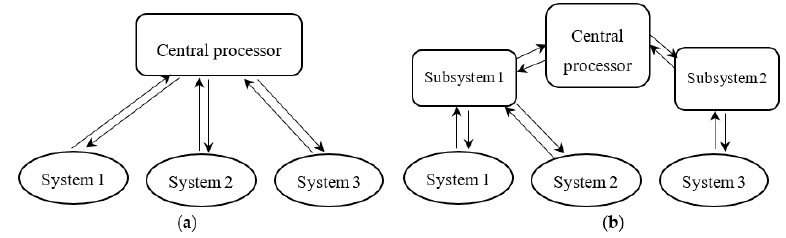
Figure 8. Centralized control strategy for large-scale systems: ( a ) pure centralized structure and ( b ) hierarchical centralized structure.